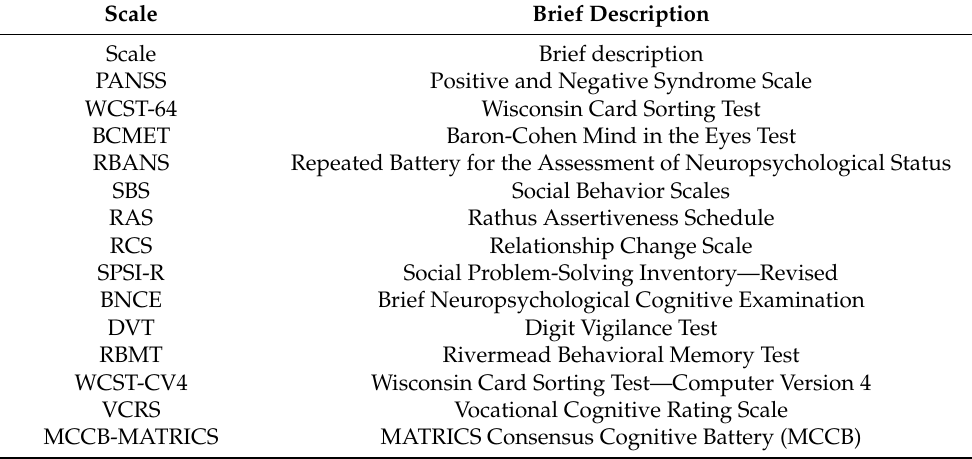
Table 1. Classification of assessment